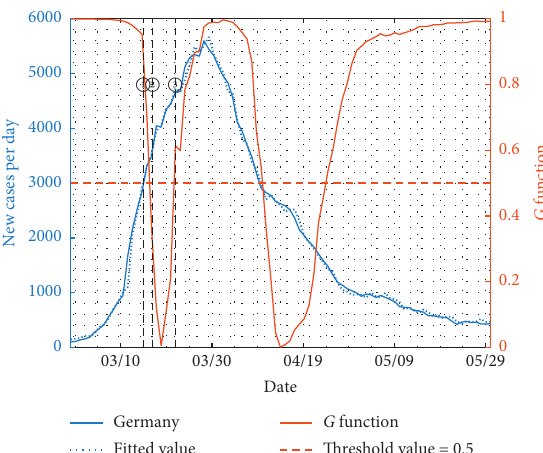
Figure 5: The fitting result of Germany. The left axis shows the daily confirmed cases for the real data after smoothness (blue solid line) and its fitted values by the STAR model (blue dashed line). The right axis shows the value of nonlinear functions G changing with time (orange solid line) and the reference line with threshold 0.5 (orange dashed line). The vertical dotted line indicates the sequential released policies: ① close schools across the country, ② upgrade the risk level of the outbreak to “high,” and ③ tighten controls on social activities and gatherings.